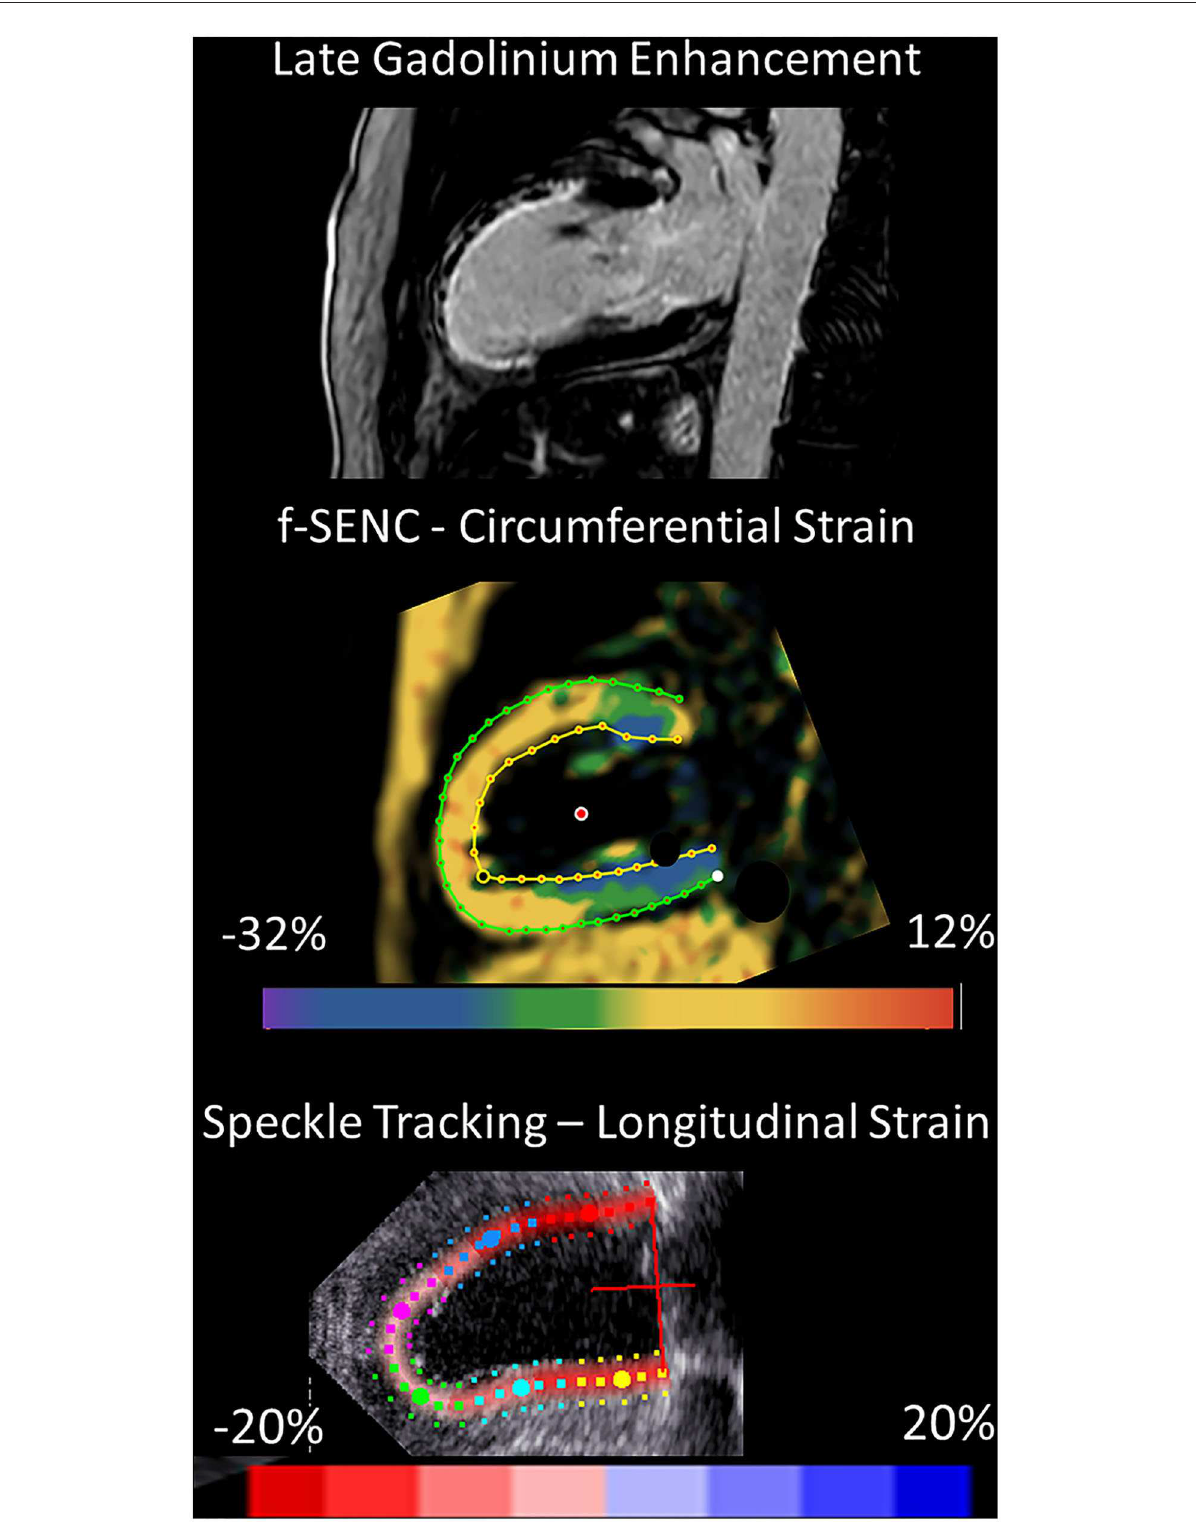
FIGURE7 2-chamber view of an extensive anterior infarction with the transmural extent of late gadolinium enhancement and zones of no-reflow in the superior viewport, distinctly positive circumferential strain by fast-SENC in the scar area (yellow, middle viewport) and the corresponding speckle tracking longitudinal strain from 2DEcho (pale pink, lower